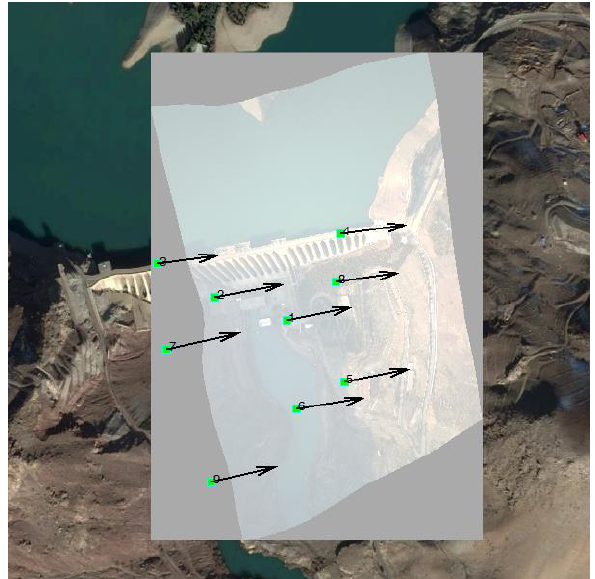
Figure 10. Residual vectors obtained by differencing control point positions in the case of geo-located image resulted from coarse geo-location